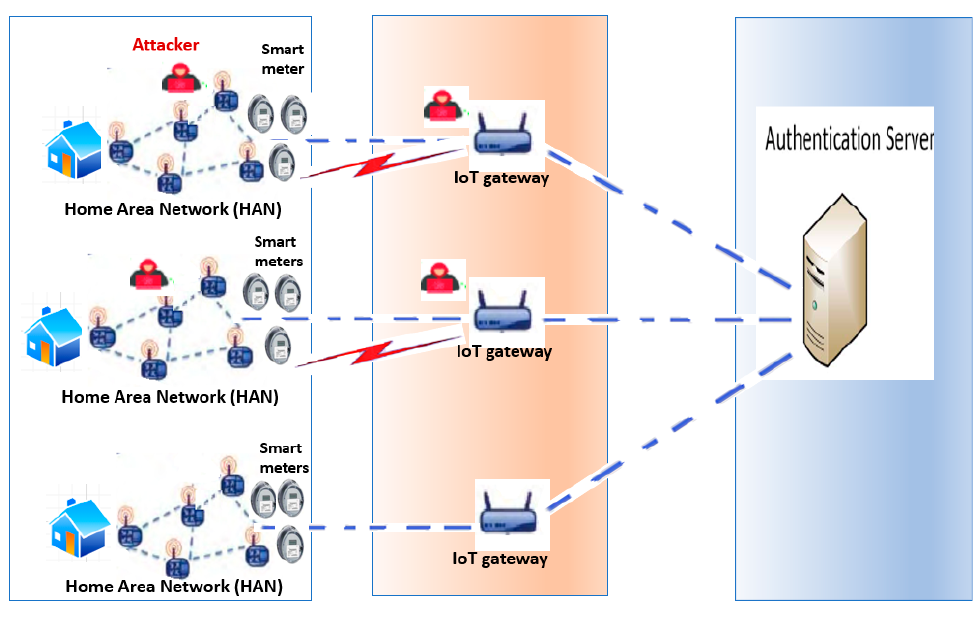
Figure 2. System model.